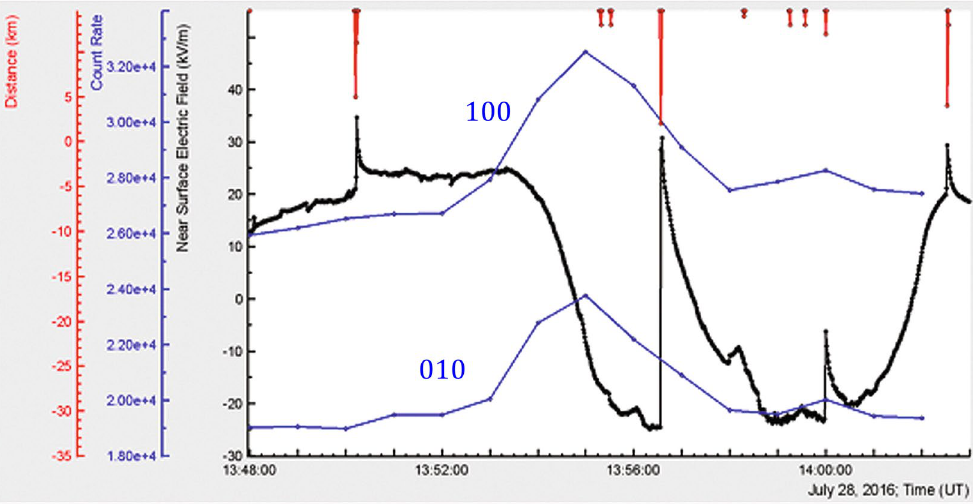
Figure 1. One-minute time-series of STAND1 detector: the count rate combinations 100 and 010 correspond to signals only from upper and middle scintillation detectors, respectively. Flux enhancement at 13:55–13:56 UT is ~34% (44 σ ). Electric field decreased from + 25 kV/m at 13:53:25 UT to − 24 kV/m at 13:55:25 UT. Distances to 4 nearby lightning flashes measured by the same EFM-100 device are 4.8, 1.9, 11.7, and 3.8 km from left to right, respectively. Other 6 lightning flashes shown in the top of picture occurred at distances more than 10